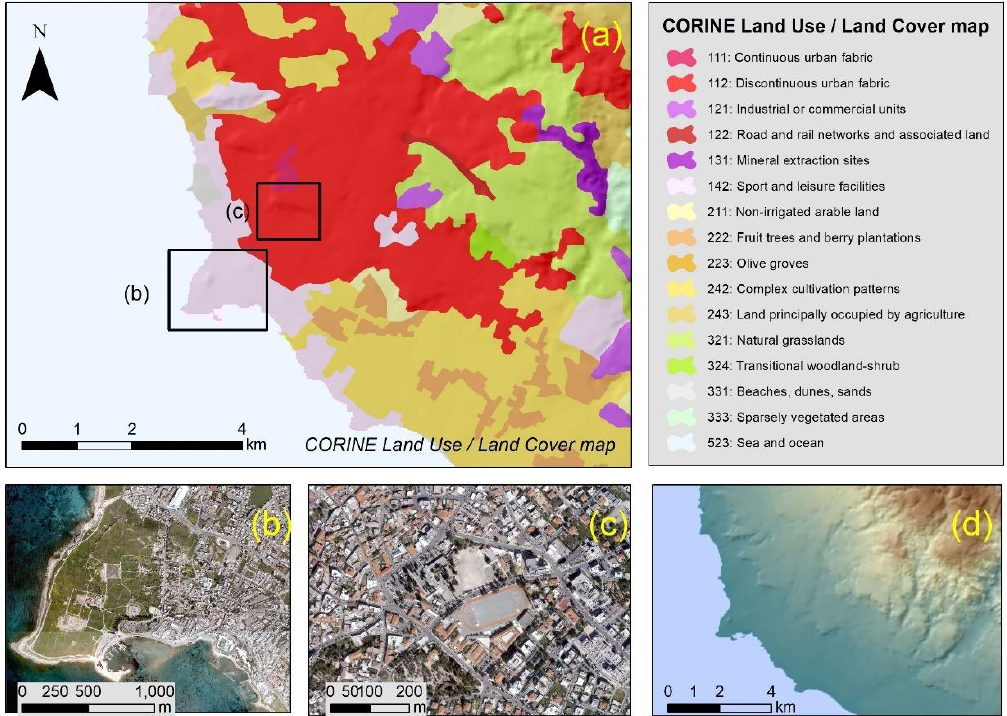
Figure 1. The selected case study area located in the western part of Cyprus. The various thematic classes from the Corine Land Use Land Cover 2018 dataset [13] over the area of interest are shown in ( a ), while some high-resolution aerial orthophotos provided by the Department of Land and Surveyors (scale 1:5000) are shown in ( b ) (archaeological site of Nea Paphos) and ( c ) (historical Centre of Paphos town). ( d ) shows the elevation of the area.